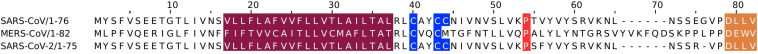
A sequence comparison of the envelope (E) protein amino acid sequences for the pathogenic human coronaviruses (hCoVs). The comparison was constructed using Jalview software (v 2.11.1.0) and the important sequence features transmembrane domain (TMD) (brown), conserved cysteine (blue) and proline (red) residues, and the PDZ-binding motif (PBM) (orange) are indicated. The E protein reference amino acid sequences for SARS-CoV (P59637), MERS-CoV (K9N5R3), and SARS-CoV-2 (QHD43418.1), along with their accession IDs, were obtained from the NCBI database.